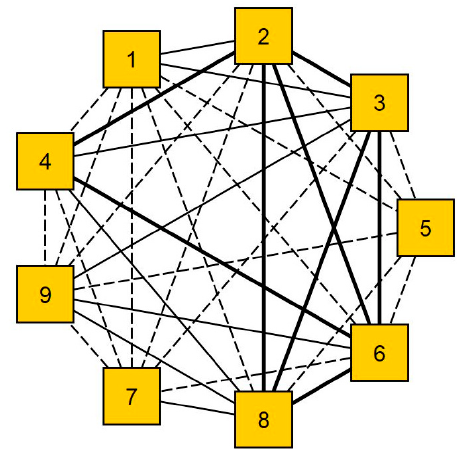
Figure 1. A network of the filtered data set comprising nine abattoirs (squares 1–9). The edges represent the number of linking farms. Thick line: 500–1,500 farms, solid line: 100–499 farms, dashed line: 1–99 farms.